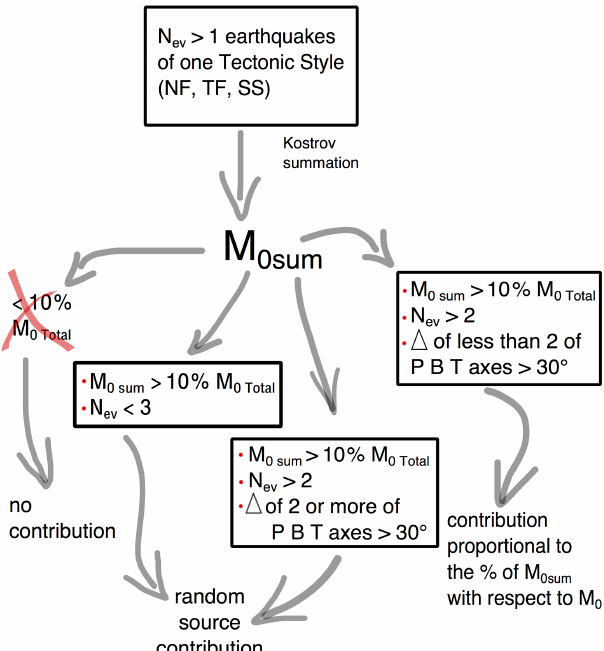
Figure 5. Sketch of the decision-making process applied to each zone and to each tectonic style group of earthquakes. N ev is the number of available earthquakes; M 0sum is the seismic moment ob- tained summing the N ev M 0 ; M 0Total is the cumulative seismic mo- ment release in the singular zone independently of the tectonic style of events; (cid:49) is the angular distance between the P, T, and B axes of a single focal mechanism involved in the summation and those of the cumulative